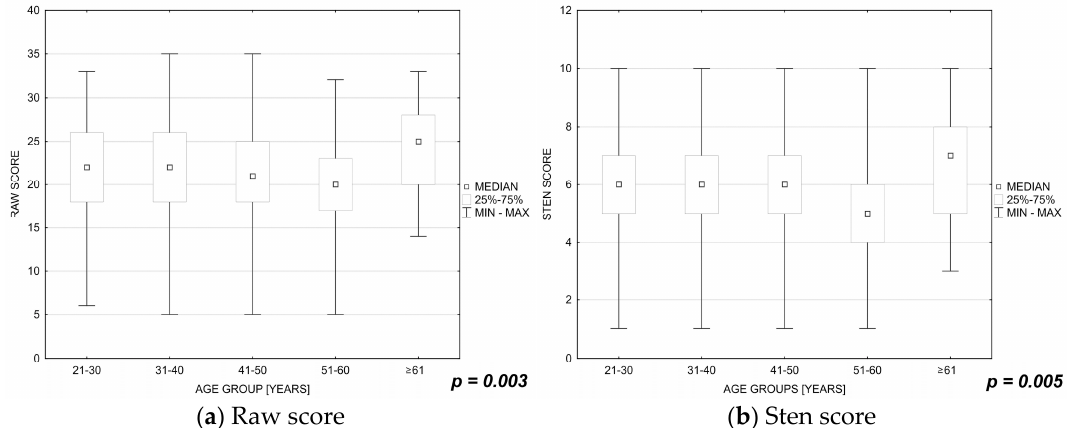
Figure 2. ( a , b ) Influence of the nurses’ ages on their satisfaction with life.